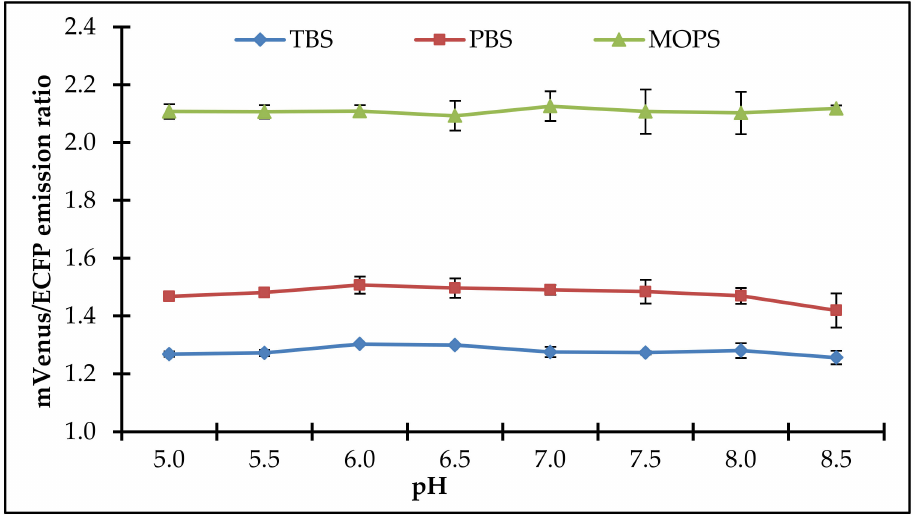
Figure 4. FLIP-SP sensor sensitivity toward pH with various bu ff ers. Values are the mean of three replicates. Vertical bars show the standard